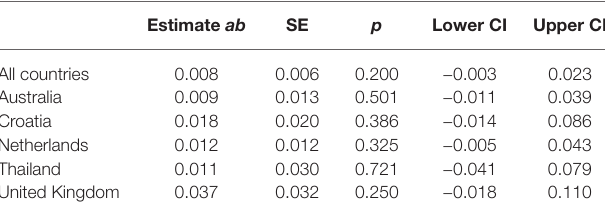
TABLE 4 | Results overall and across countries testing if the relationship between gender roles and crying intensity is mediated by beliefs that crying is helpful.